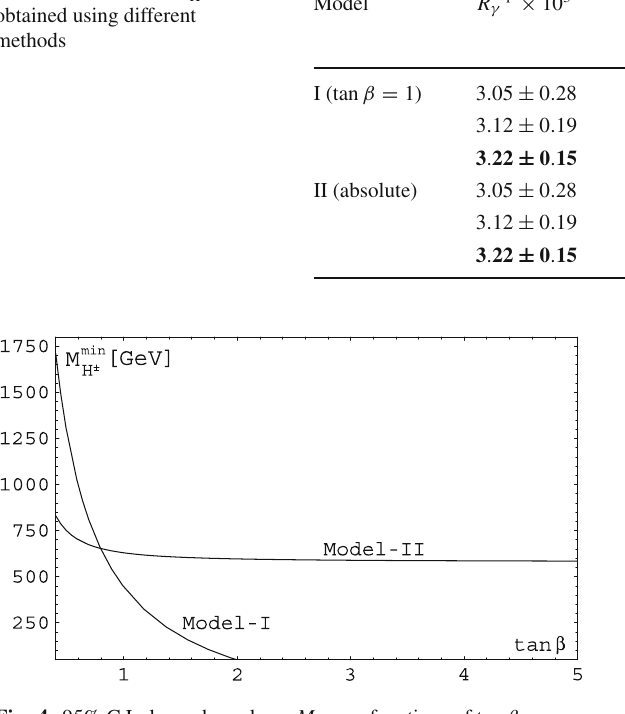
Fig. 4 95% C.L. lower bounds on M H ± as functions of tan β